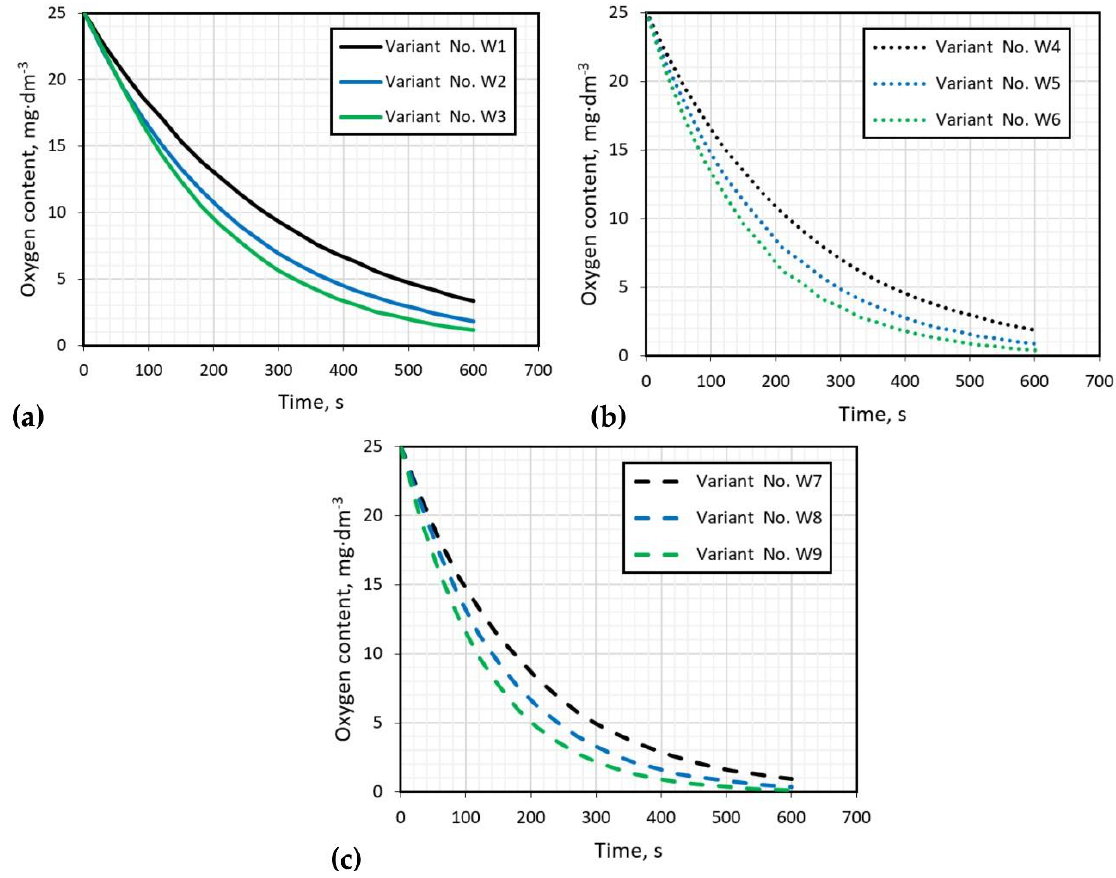
Figure 5. Results of oxygen removal, impeller speed: ( a ) 300 rpm, ( b ) 400 rpm, ( c ) 500 rpm.